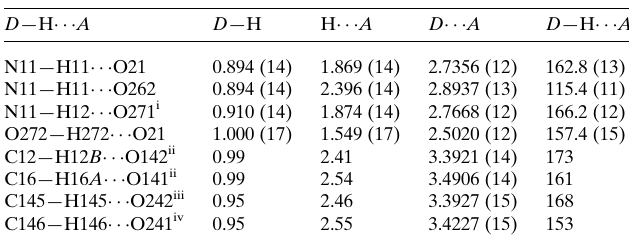
Table 2 Hydrogen-bond geometry (A˚ , (cid:3) ) for